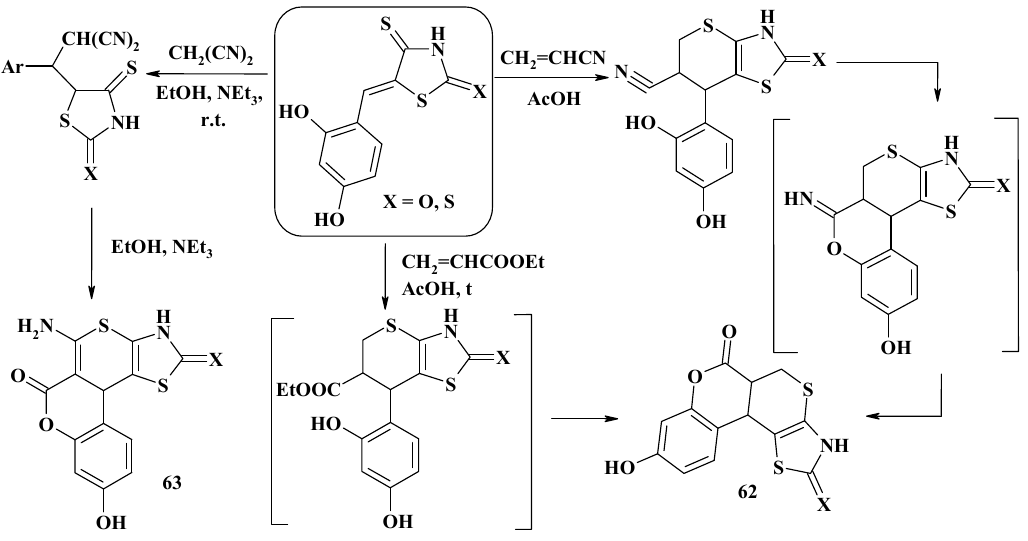
Scheme 20. Tandem reaction of 5-(2,4-dihydroxyphenylmetylidene)iso(thio)rhodanines with ethyl acrylate and acrylonitrile.